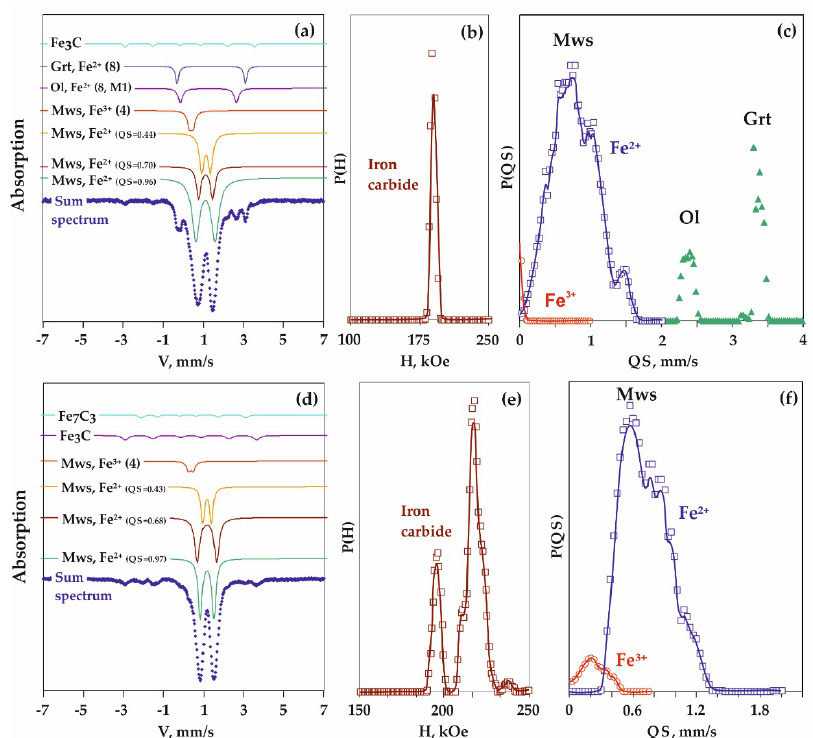
Figure 9. Mössbauer spectra of samples produced in the carbonate-iron system (N. 1287 ( a – c ) and 1249 ( d – f )) as well as components of these spectra ( a,d ), the probability distribution of hyperfine magnetic fields (H) on iron nuclei ( b,e ) and the probability distribution of quadrupole splittings P(QS) in experimental spectra of magnesiowüstite and silicates ( c,f ). Table 4. Results of the Mössbauer spectroscopy of magnesiowüstite formed in the carbonate-oxide-metal and carbonate-oxide systems (P = 6.3 GPa).